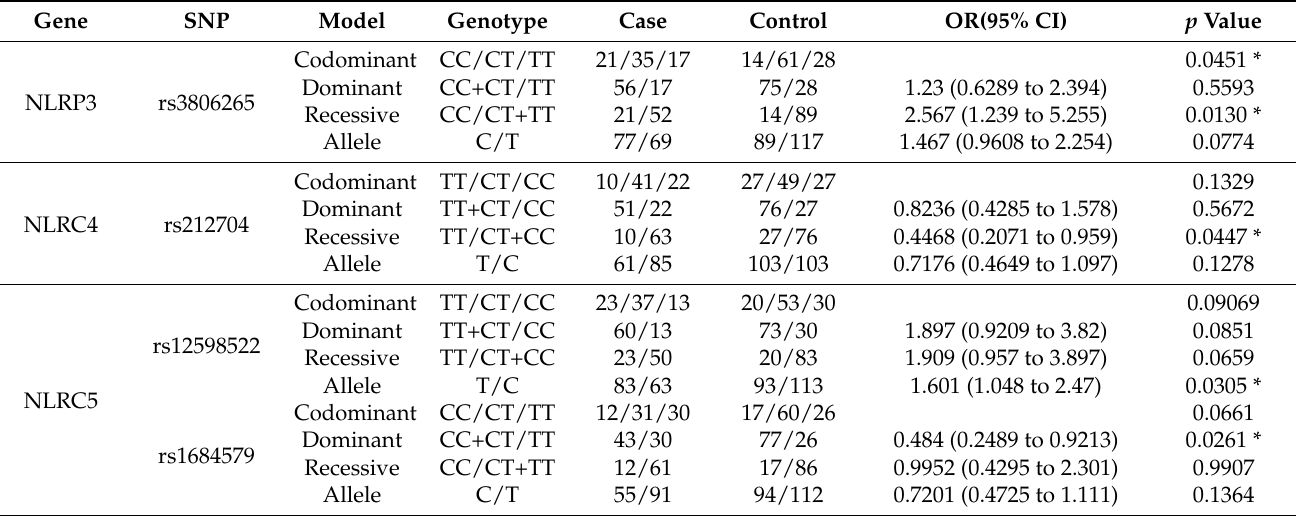
Table 3. Genotype distribution of NLRP3 rs3806265, NLRC4 rs212704, NLRC5 rs1684579, and rs12598522 in pulmonary aspergillosis cases and controls.